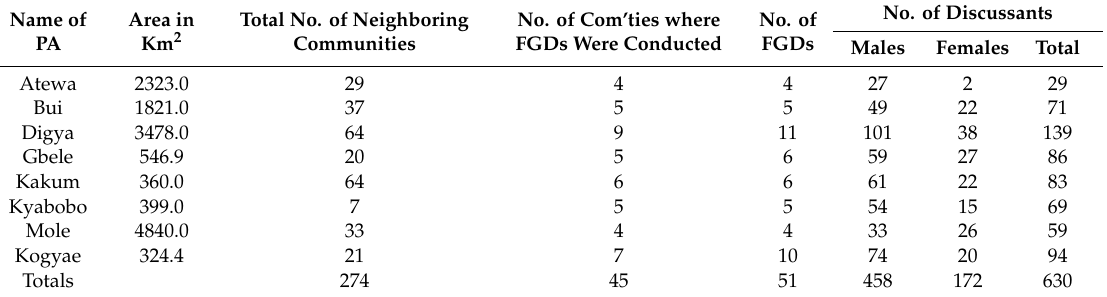
Table 1. Focus Group Discussions in Respective Protected areas